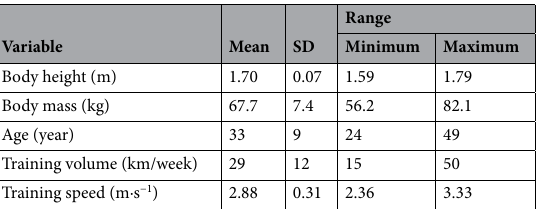
Table 1. Participants’ characteristics: anthropometrics and self-reported training habits.